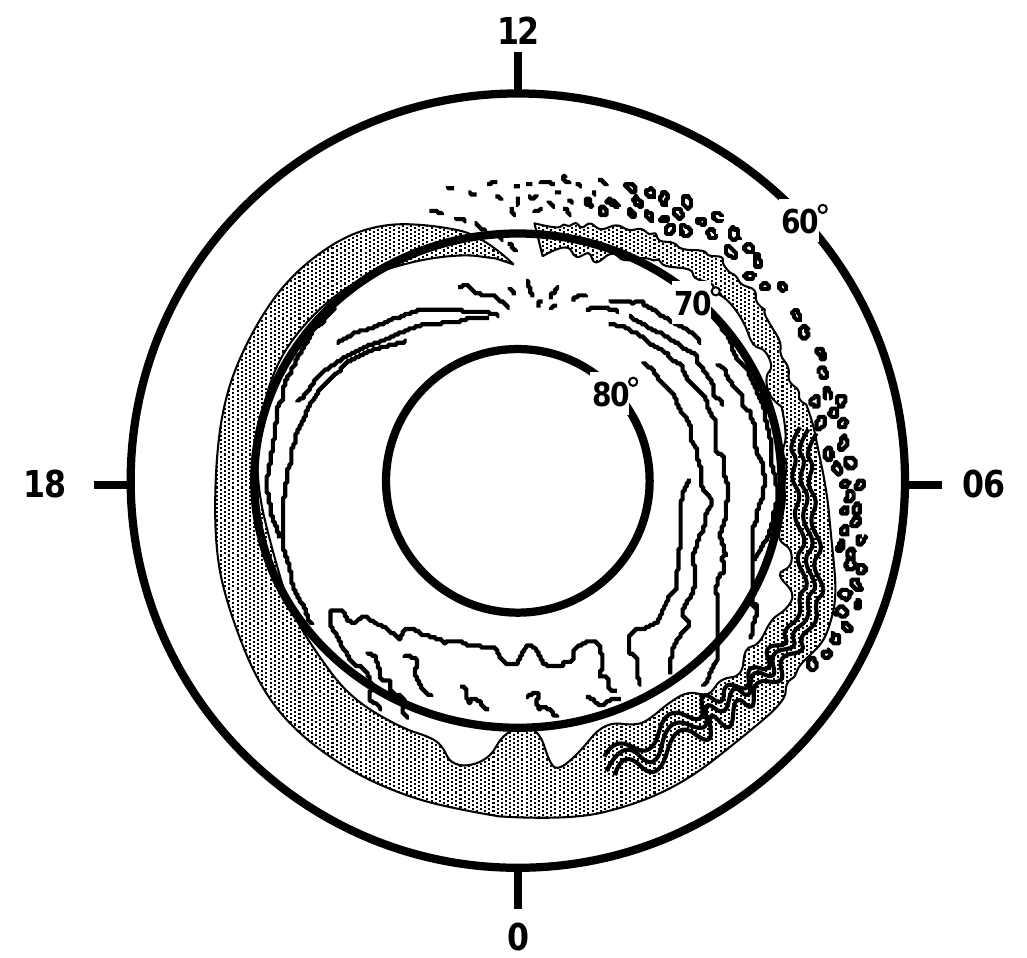
Fig. 1. Schematic of auroral distribution modified slightly from Akasofu (1966). Note that the original figure was constructed on the basis of ground-based observations made before global imaging from space was possible. As such, it incorporates a mixture of diurnal (local time) and temporal (universal time)